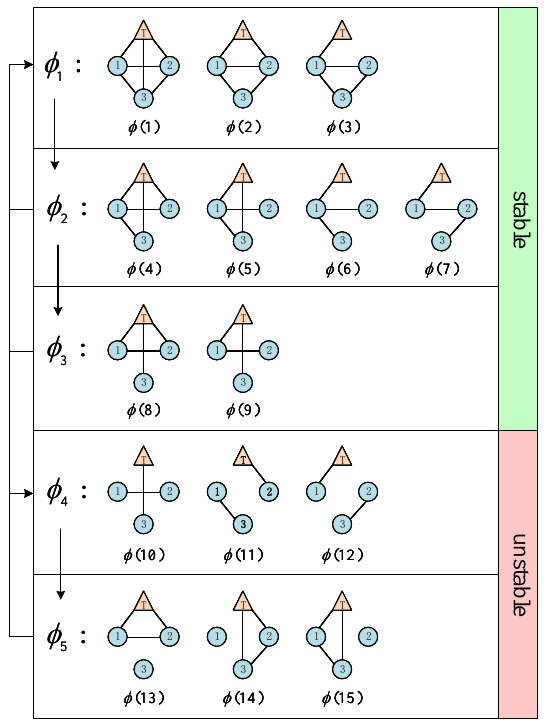
Figure 2. An example of quasi-cyclic switching